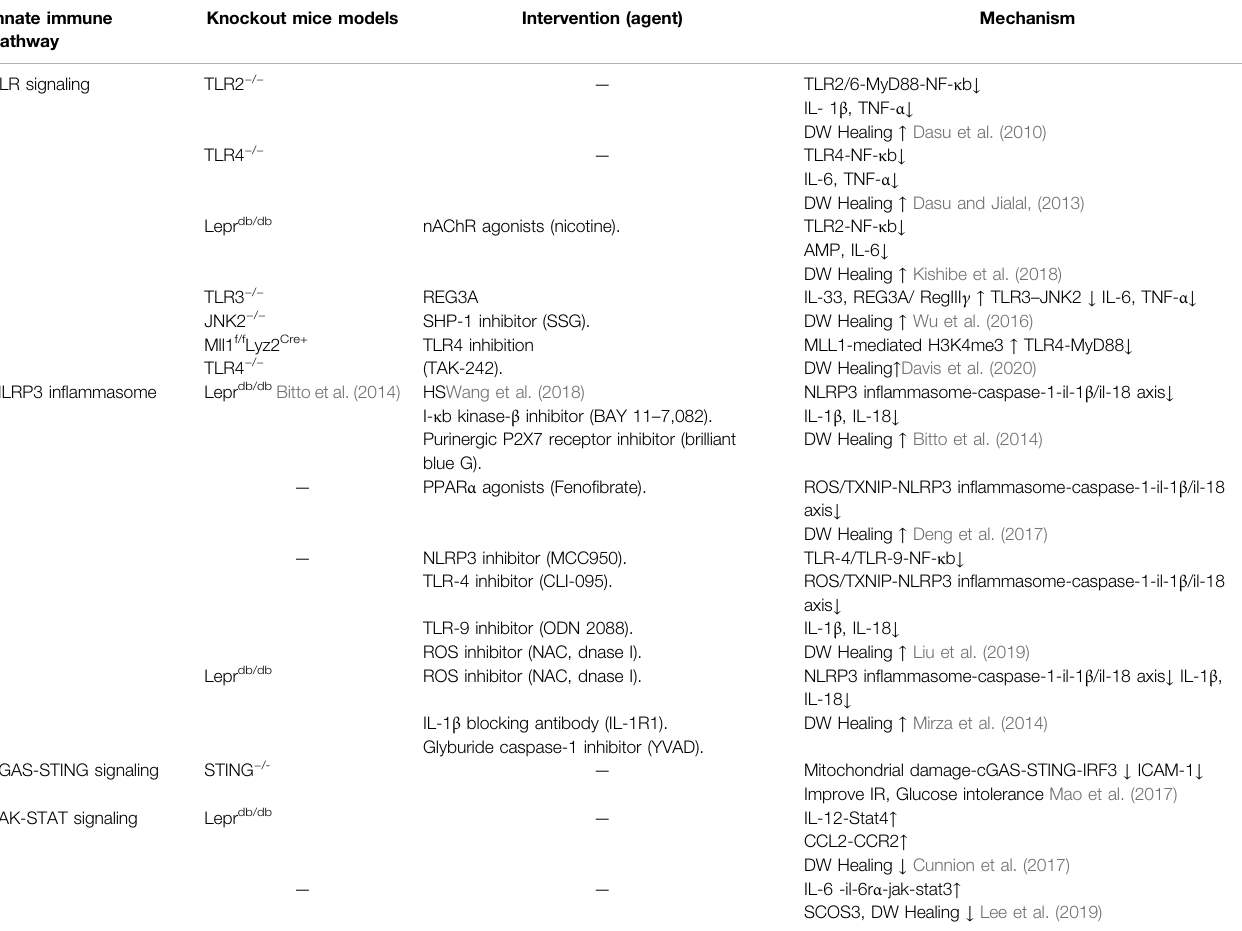
TABLE 3 | Effects of modulating innate immunity pathways in experimental